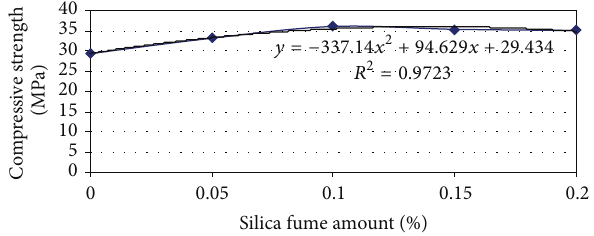
Figure 4: The relation between silica fume additive and occupancy in concrete with 30/70 fine/large aggregate ratios.